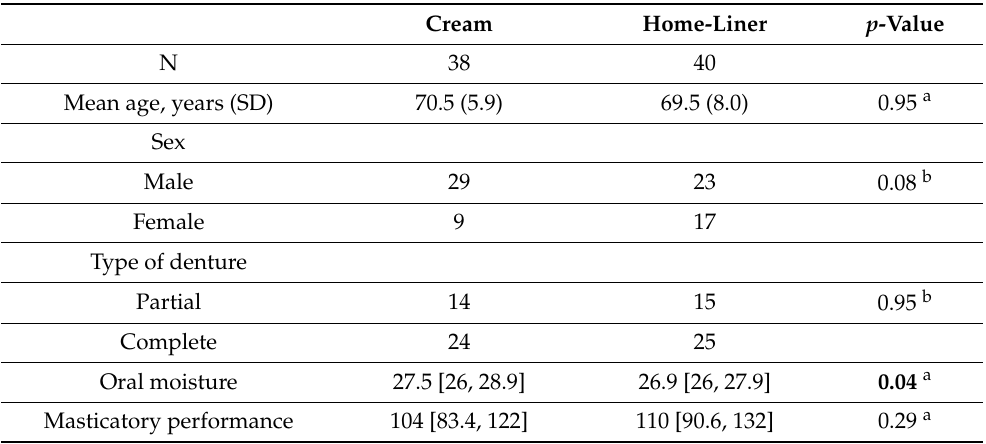
Table 1. Characteristics of participants.